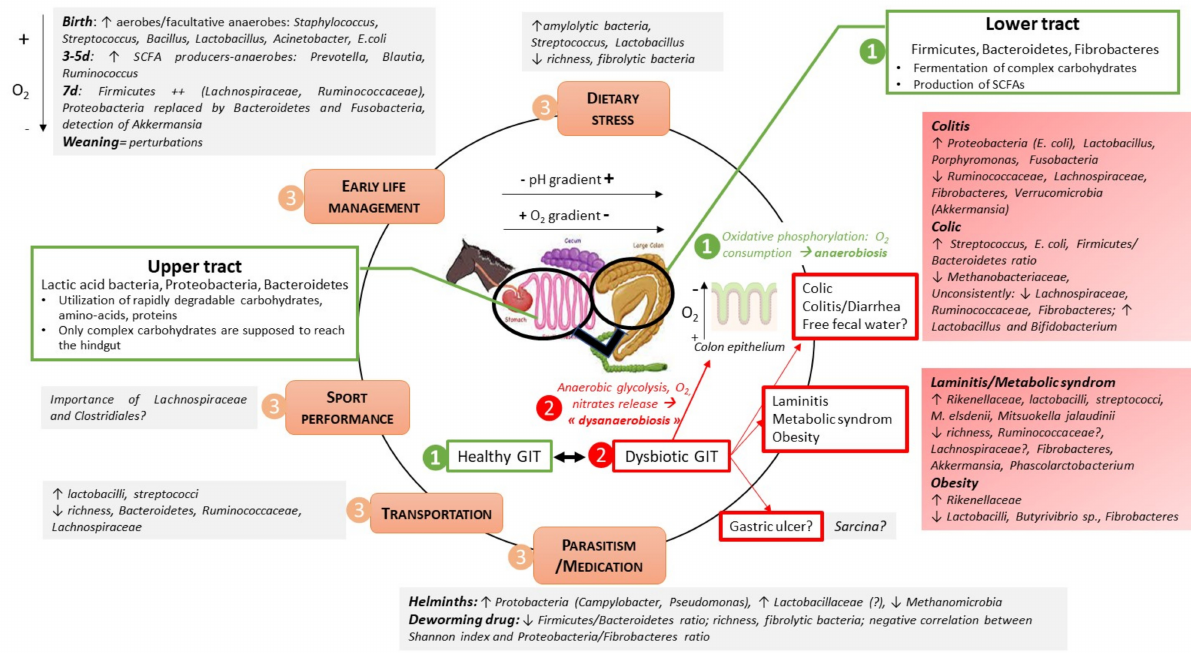
Figure 5. Factors contributing to GIT microbiota health or dysbiotic state, and identification of potential interesting microbial biomarkers. Green boxes: balanced microbiota (1); red boxes: dysbiotic states (2); orange boxes: factors that can alter the microbiota and lead to a dysbiotic state (3). Beige boxes gather the main bacteria that are affected by the dysbiotic situations. In this figure, the evolution of the oxygen gradient with age, GIT segment and at colonocyte level, as well as the importance of the crosstalk between colonocytes and microbes, and the possible switch in colonocyte metabolism are also